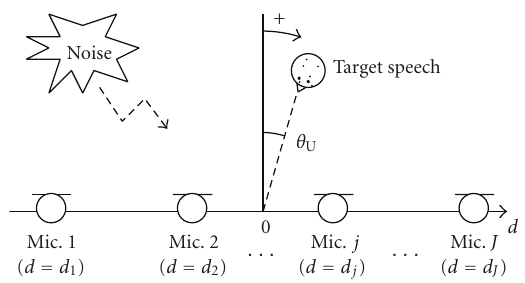
Figure 3: Configuration of microphone array and